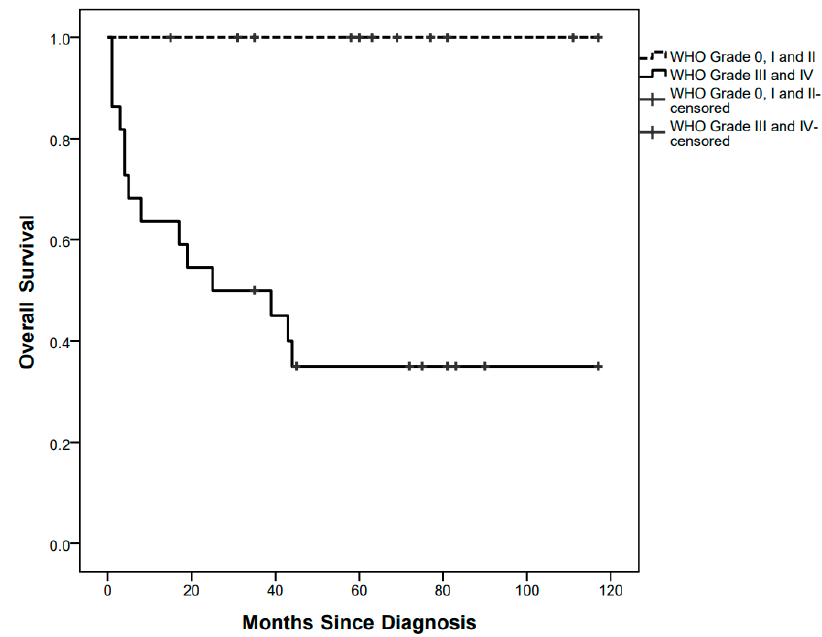
Figure 3. Overall survival curves by low grade and high-grade pathology.